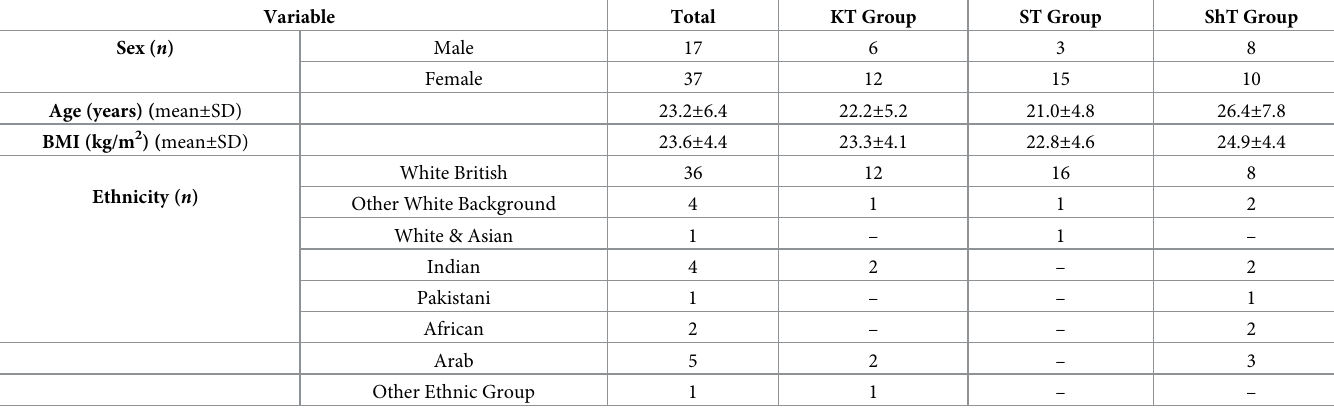
Table 1. Demographic characteristics and anthropometric data of all participants.